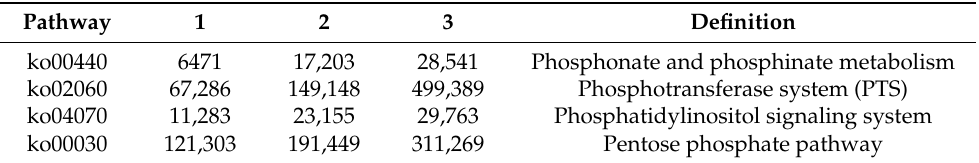
Table 3. The abundance of the metabolic